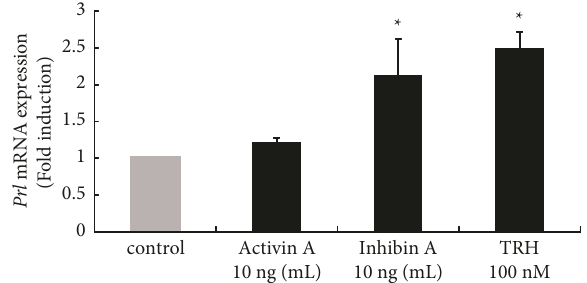
Figure 8: Effect of activin A and inhibin A on Prl gene expression in lactotroph GH3 cells. GH3 cells were stimulated with the in- dicated concentrations of activin A or inhibin A for 24h After stimulation, mRNA was extracted and reverse transcribed, and Prl mRNA levels were measured by quantitative RT-PCR. Samples from each experimental group were run in duplicate and nor- malized to the mRNA levels of the housekeeping gene Gapdh. The results are expressed as fold induction over unstimulated cells and are presented as the mean ± SEM of three independent experi- ments. ∗ P < 0 . 05 versus the